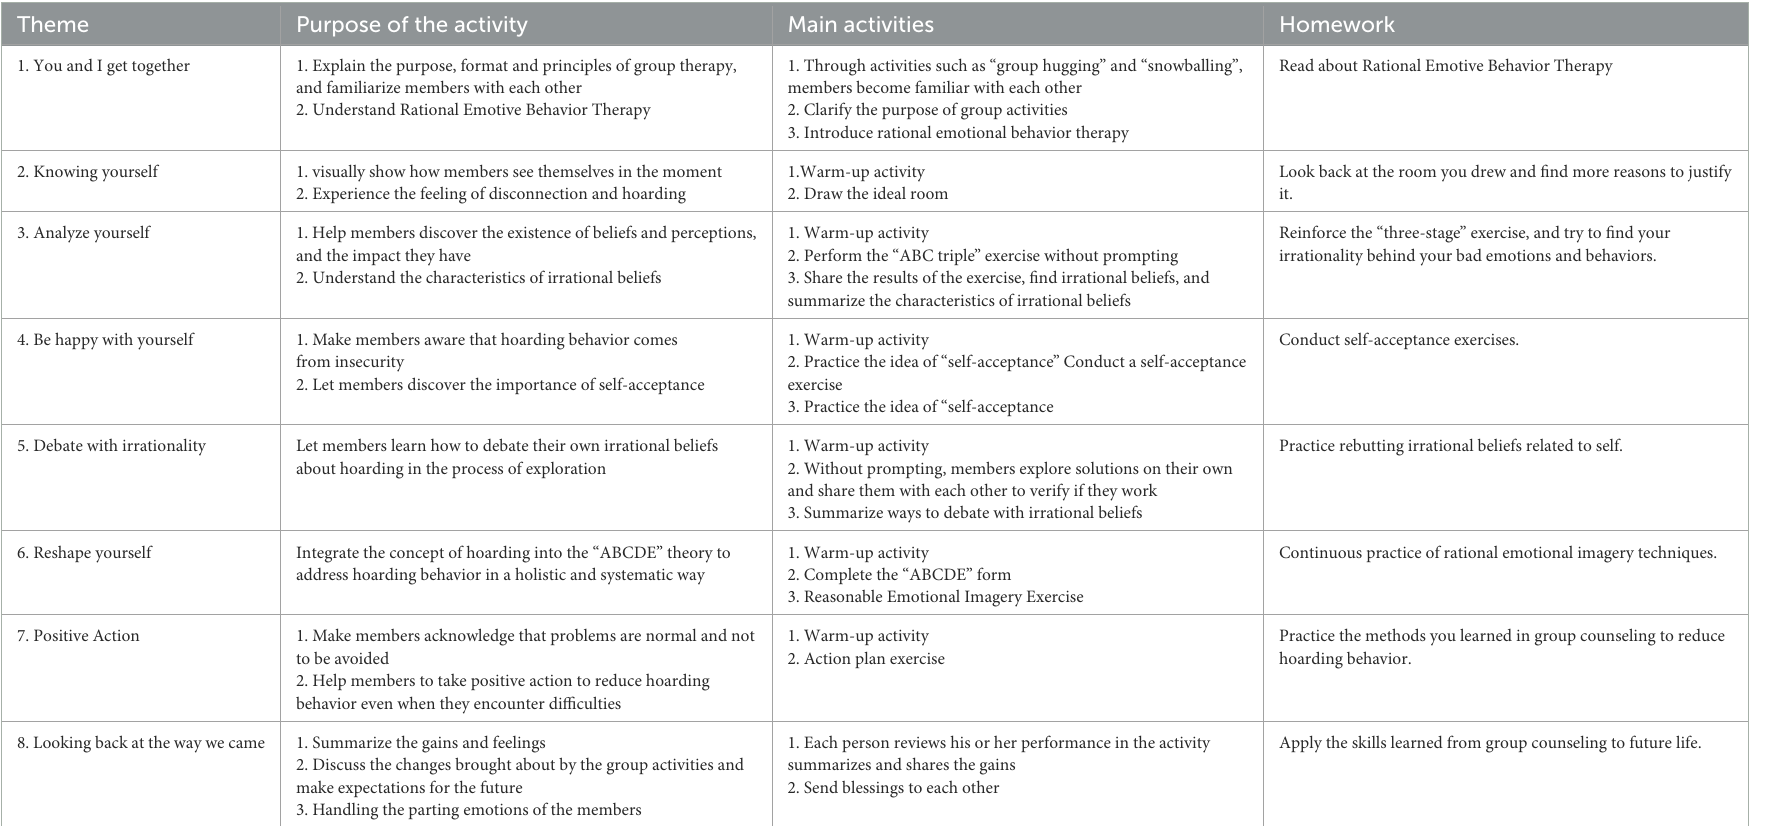
TABLE 2 Rational emotive behavior therapy intervention